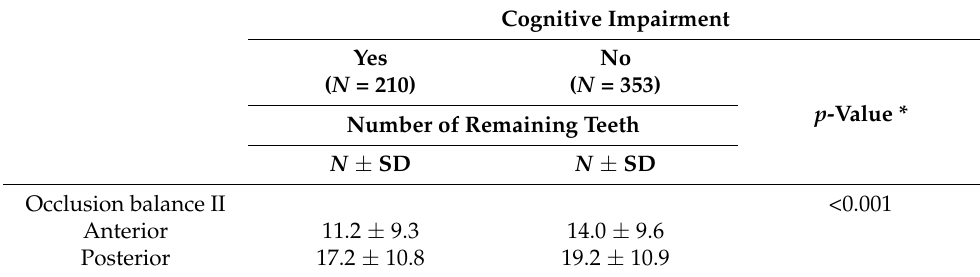
Table 3. Anterior and posterior balanced occlusion according to cognitive function and number of remaining teeth.